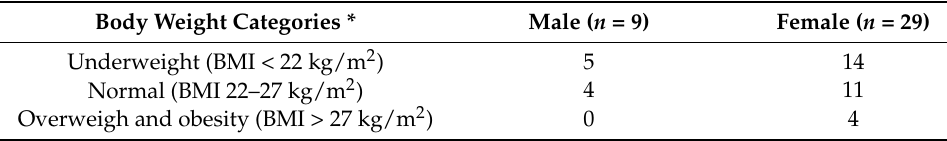
Table 3. Baseline body weight status of